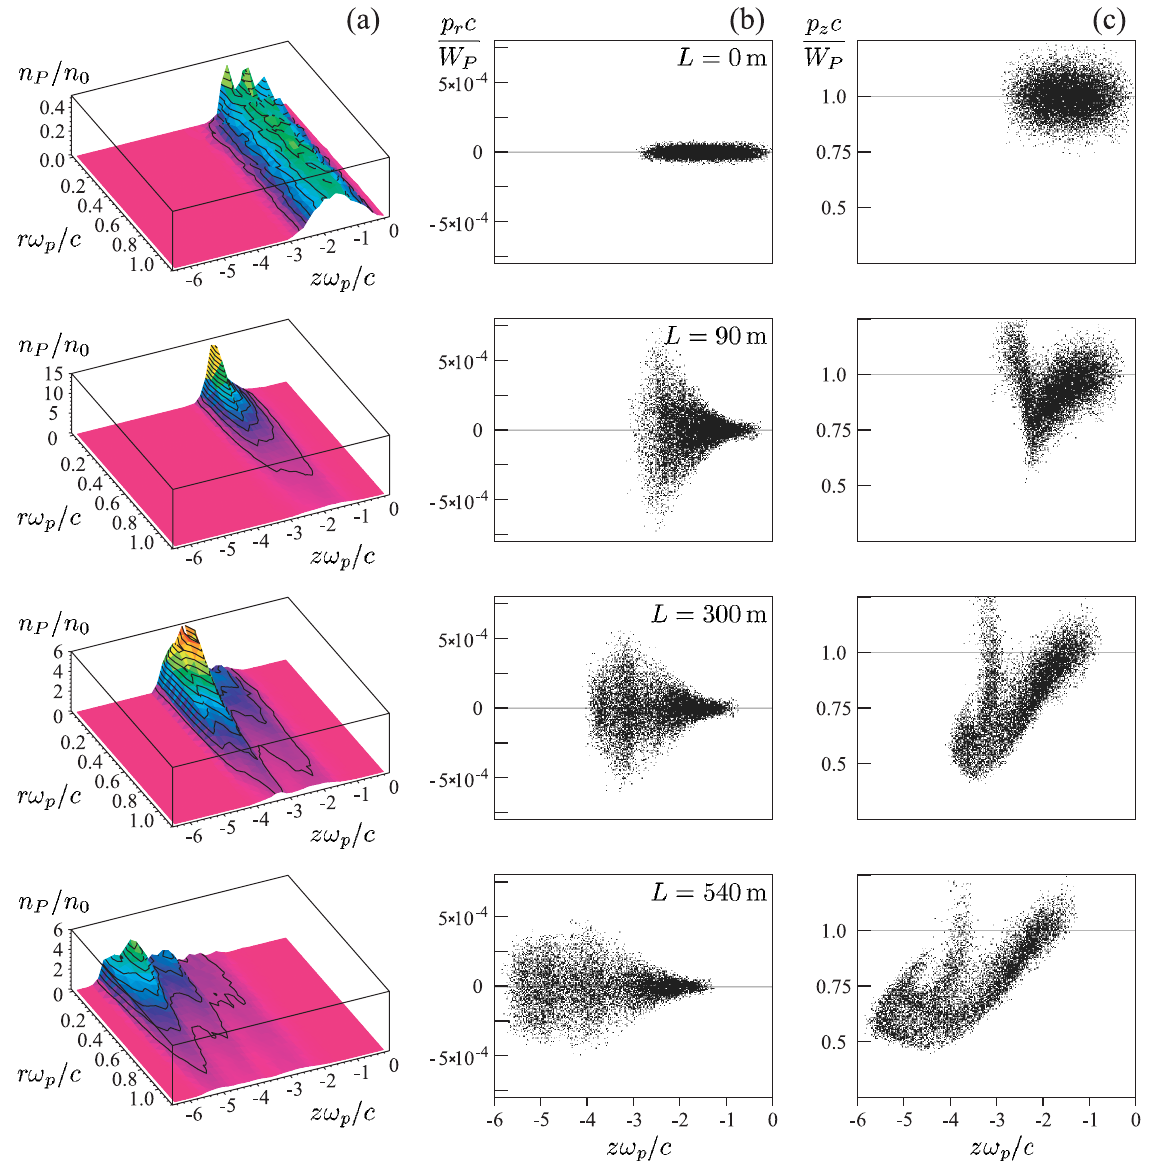
FIG. 3. (Color) Driver density distribution (a), radial momentum p r of driver protons versus longitudinal coordinate z (b), and longitudinal phase portrait of the driver (c) at four propagation distances: L ¼ 0 m , 90 m, 300 m, and 540